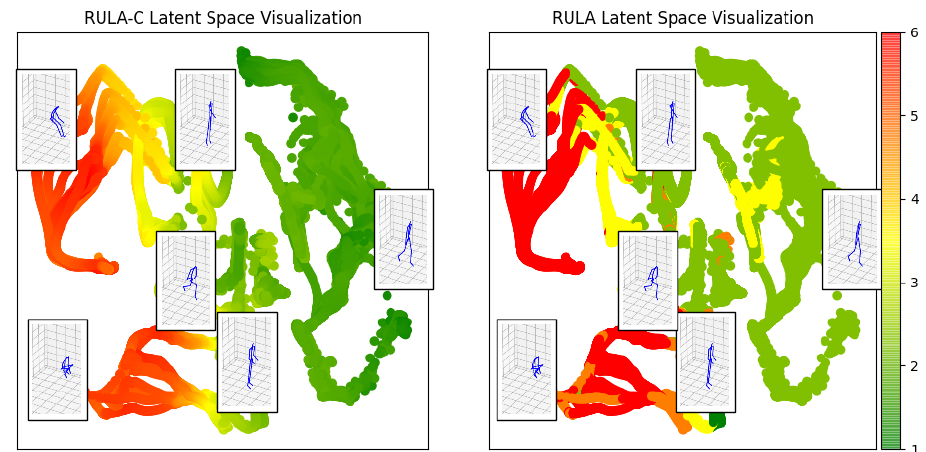
Figure 5. Latent space representation: in this plot, some examples of movements from the dataset of [38] colored according to the ergonomic evaluation. The postures associated with some 2D points in the latent space are shown. On the right, the scale of the colors corresponds to the ergonomic scores where: 1 (green) corresponds to the safer postures while 7 (red) represents the postures less